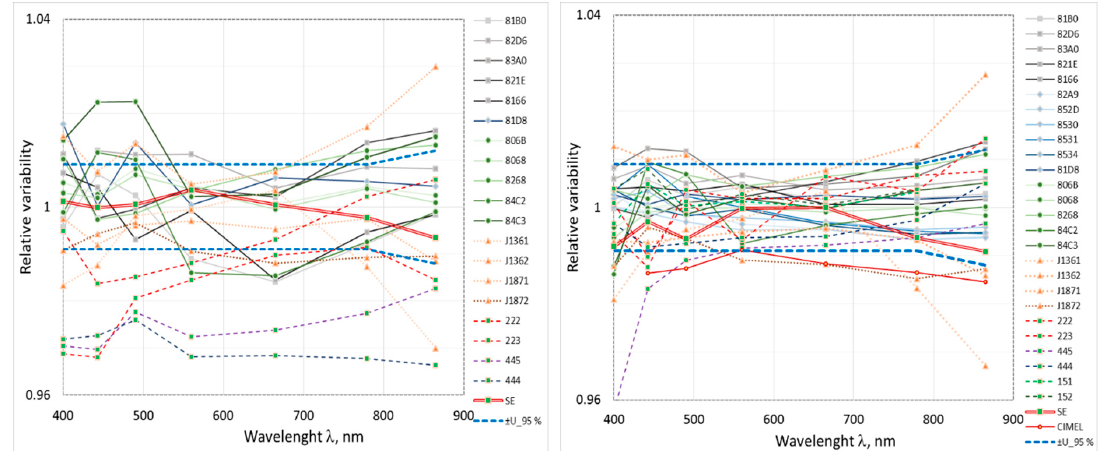
Figure 5. Low intensity radiance; agreement just after receiving data from participants (left), and after reviewing data by pilot, corrections submitted by participants and/or unified data handling by pilot (right). Blue dashed lines—expanded uncertainty covering 95% of all data points on the right graph. Solid lines—RAMSES sensors; dashed lines—HyperOCR sensors; double line—SR-3500; dotted lines —WISP-3 sensors.